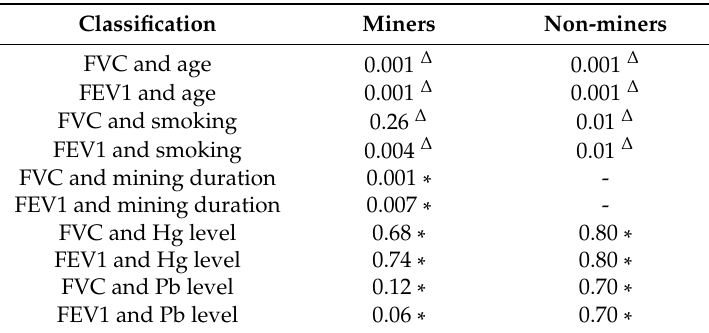
Table 5. Correlation among the variables in miners and non-miners.